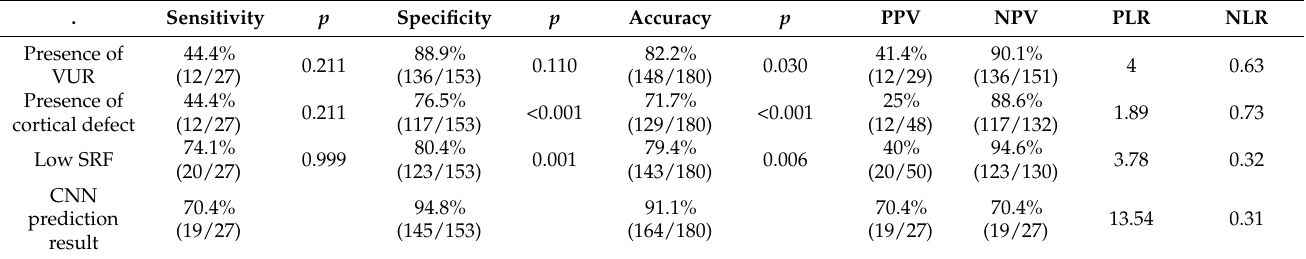
Table 2. Diagnostic efficiency for recurrent UTI in each independent variable.